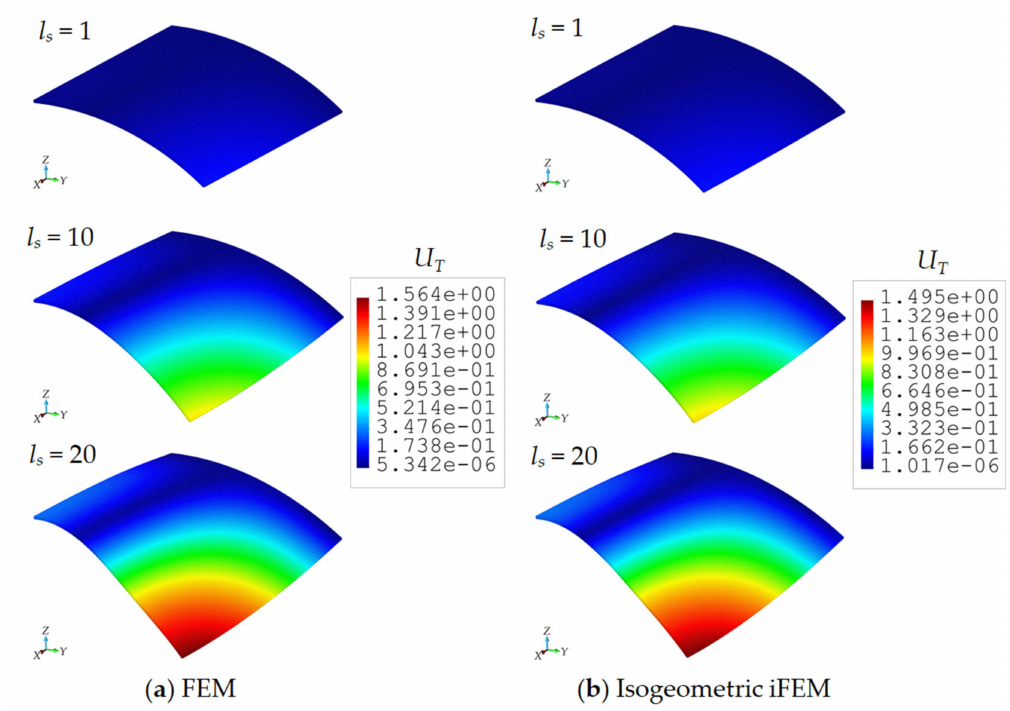
Figure 9. Contour plots of U T displacements on the deformed shape (magnification factor of 3) of Scordelis–Lo roof: Comparison between high-fidelity FEM and isogeometric iFEM (n e = 4)